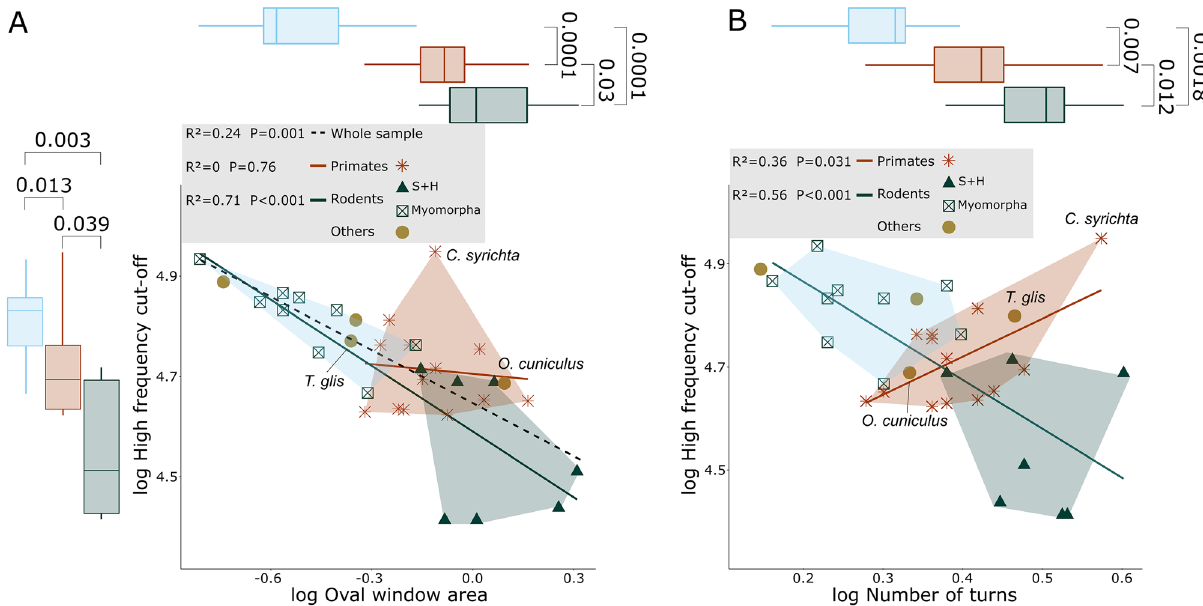
Figure 7. Selected scatterplots for high frequency cut-off. ( A ) Scatterplot of oval window area and ( B ) number of turns against high-frequency cut-off, with additional regression values for each separate group. Regression values were obtained by building PGLS models. Boxplots for oval window area and, number of turns and high frequency cut off are displayed. The values plotted are Wilcoxon P values and show that a significant difference in high frequency cut off values exists between all groups. S + H: Sciuromorpha and